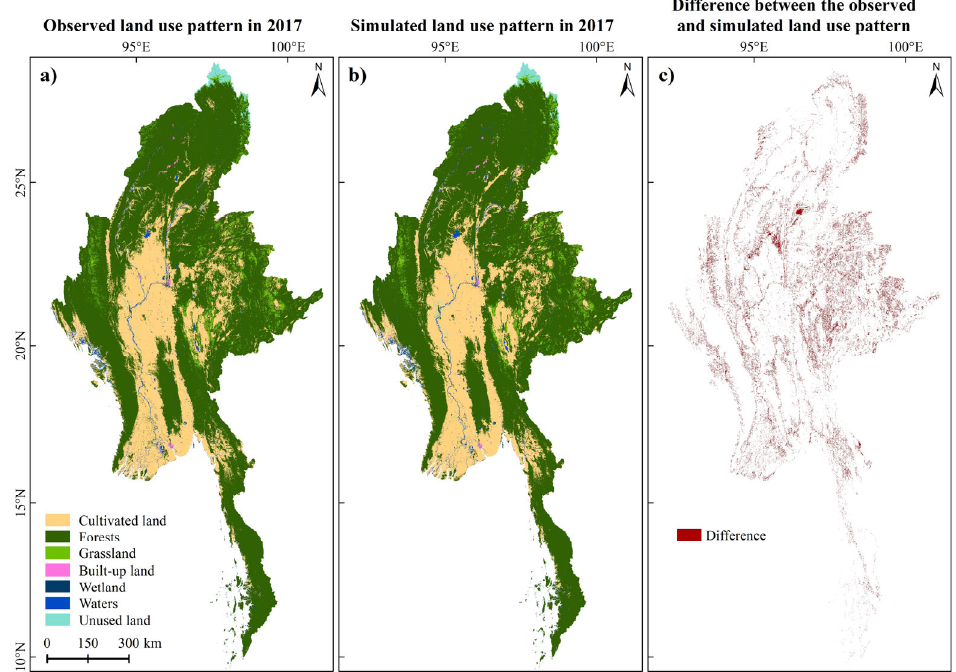
Figure 4. Distributions of the ( a ) observed and ( b ) simulated land use patterns in 2017 and the ( c ) difference between them. Table 4. Accuracies of the simulated land use patterns of Myanmar in 2013, 2015, and 2017.